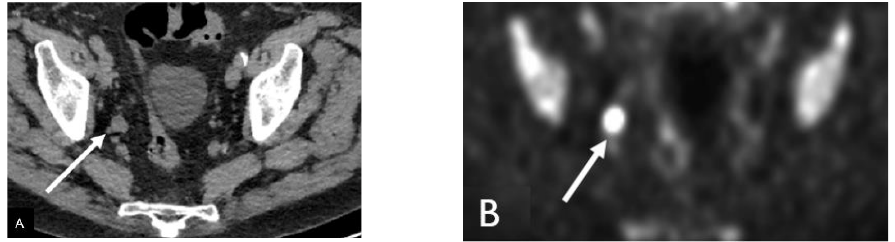
Figure 1. Sixty-nine-year-old male with history of prostate cancer, status post-prostatectomy and salvage radiation, now with rapidly rising PSA. Non-contrast-enhanced-CT (NECT), ( A ) shows an enlarged right pelvic side wall lymph node. Corresponding Fluorine-18 Fluciclovine (Axumin) PET image ( B ) shows intense radiotracer uptake concerning for recurrence and nodal disease.